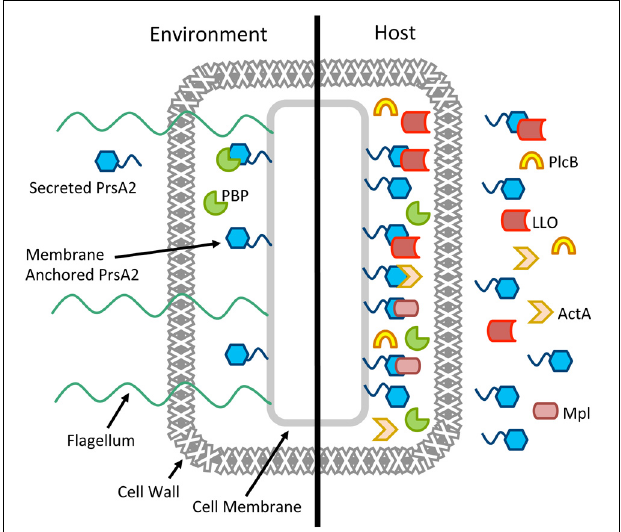
FIGURE 4 | Working model for the multiple roles of PrsA2 in L. monocytogenes . A cartoon of a single L. monocytogenes cell is shown in the environment and in the host, with PrsA2 both tethered to the cell membrane and secreted. When L. monocytogenes is in the outside environment, PrsA2 directly or indirectly is required for functional penicillin binding proteins (PBP), flagellin, and other factors that contribute to cell wall integrity, swimming motility, and resistance to osmotic stress. When L. monocytogenes is in the host, activation of the central virulence regulatory protein PrfA leads to increased expression of several secreted virulence factors as well as PrsA2, which is required for the folding and stability of listeriolysin (LLO), the Mpl protease that activates the broad-range phospholipase (PlcB), ActA, and other